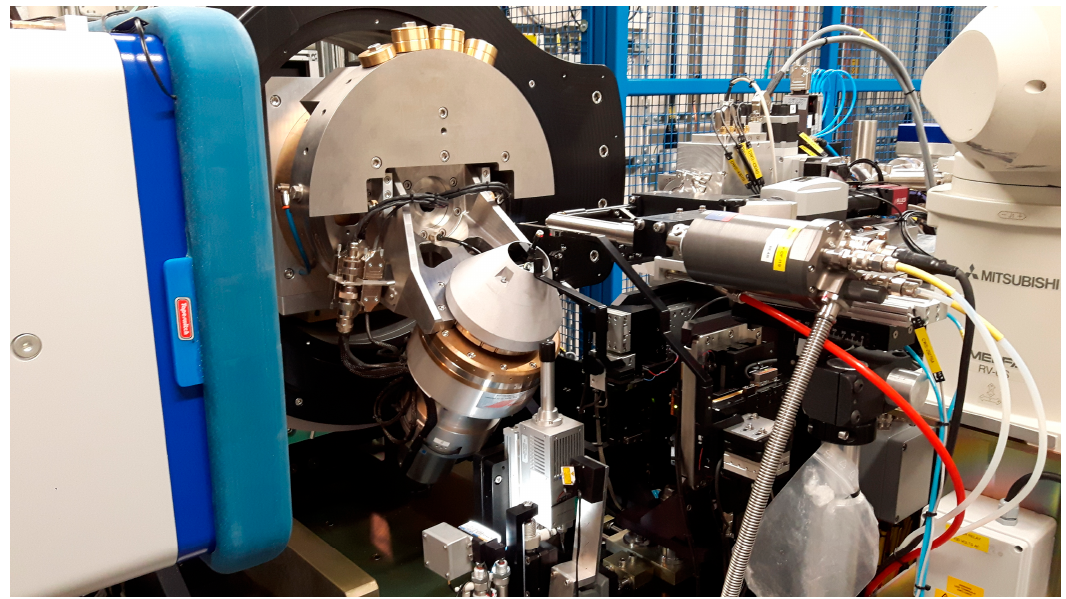
Figure 9. The complete diffractometer system in its fully assembled form. The diffractometer is shown with 2 θ = 0°, ω = 0°, φ = 0° and the detector distance set to 300 mm